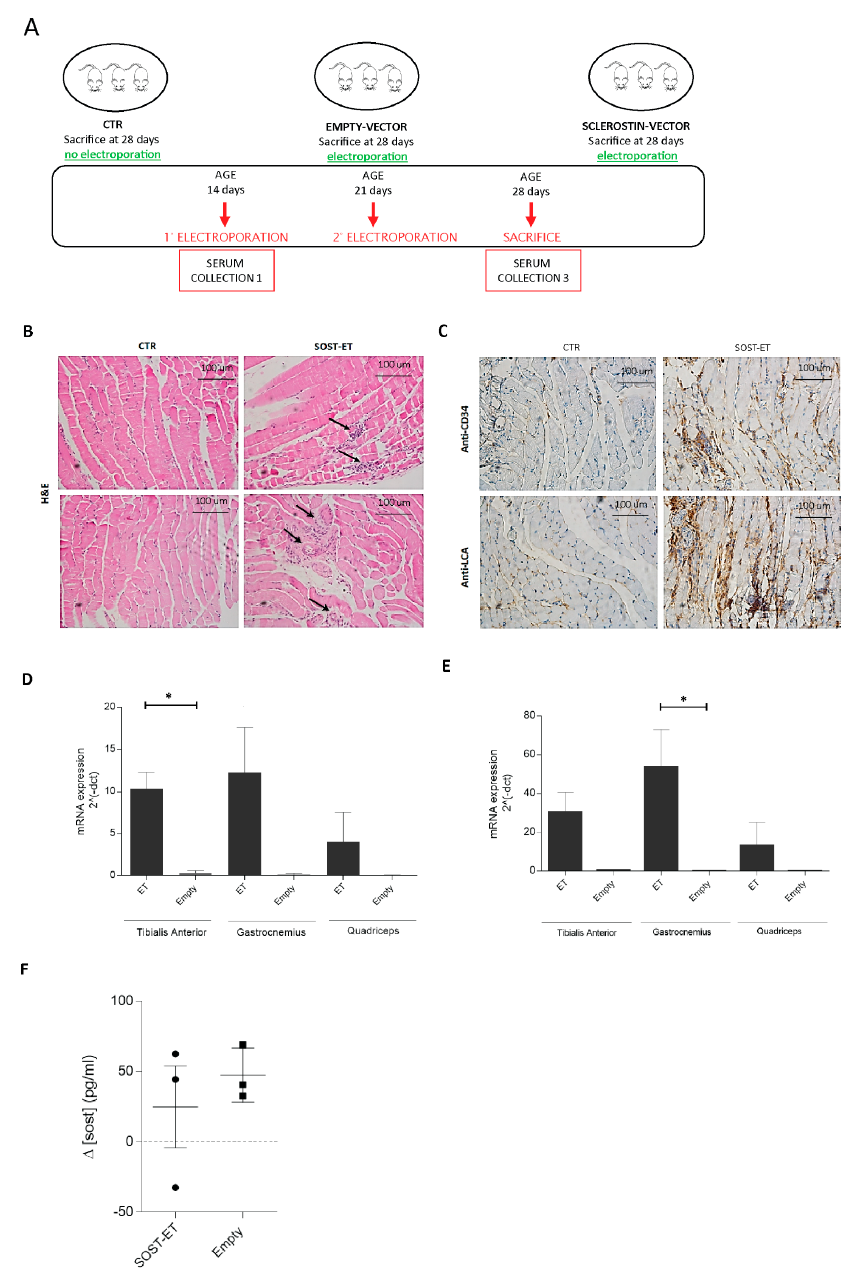
Figure 5. ( A ) Graphical scheme of the sclerostin overexpression experiment. Mice were randomly assigned to three different experimental groups: non-electroporated control (CTR) or electroporated with an empty vector or with the sclerostin vector. At the baseline time (before the first electroporation) and before sacrifice, the serum was collected from each animal. ( B , C ) The photographs show representative histological sections of the tibialis anterior of C57BL/6 mice. Magnification 20X. Sections of CTR and SOST-ET (SOST-electroporated) mice stained with H&E. The black arrows indicate inflammatory infiltrate ( B ). Sections stained with anti-CD34 and anti-LCA antibodies ( C ). ( D , E ) Exogenous myc-tagged ( D ) and total sclerostin ( E ) expression were evaluated by RT-PCR in tibialis anterior, gastrocnemius, and quadriceps femoris muscles electroporated with the SOST plasmid (ET, n = 3) or electroporated with an empty vector (Empty, n = 3, except for tibialis anterior, n = 2). Data are expressed as the means with the SEM. For each muscle, statistical analyses were performed using an unpaired t -test (two-tailed). * p < 0.05. ( F ) Serum sclerostin levels evaluated through ELISA and calculated as the delta ( ∆ ) amount of sclerostin before the electroporation as a starting level and at the moment of